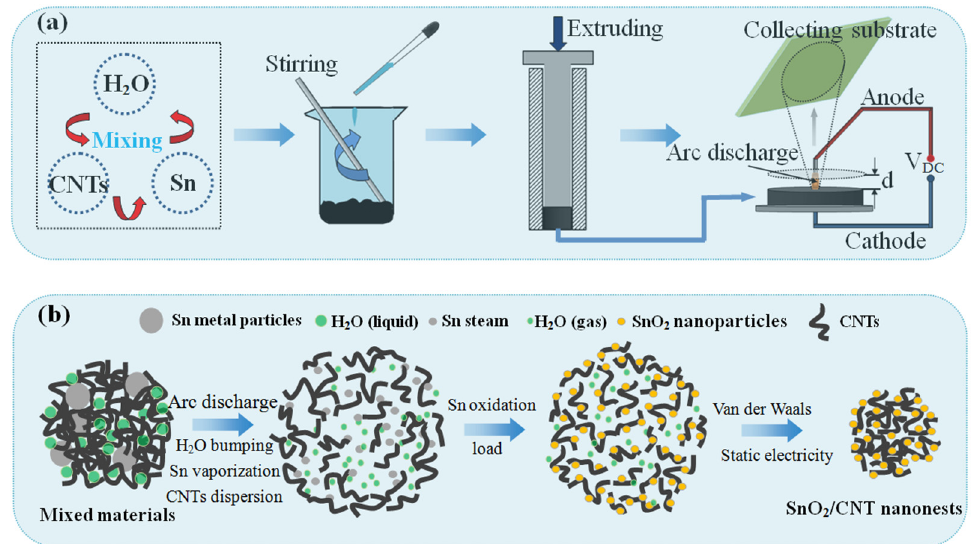
Figure 1. Schematic diagram of the preparation process of SnO 2 /CNT NNs composites. ( a ) macro- preparation process; ( b ) micro-composite mechanism. preparation process; ( b ) micro-composite